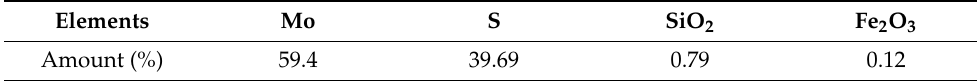
Figure 2. Size distribution of actual molybdenum ores. Table 1. Element content analysis of molybdenite by XRF. Table 2. Compositions of molybdenum ore, shown as a percentage.